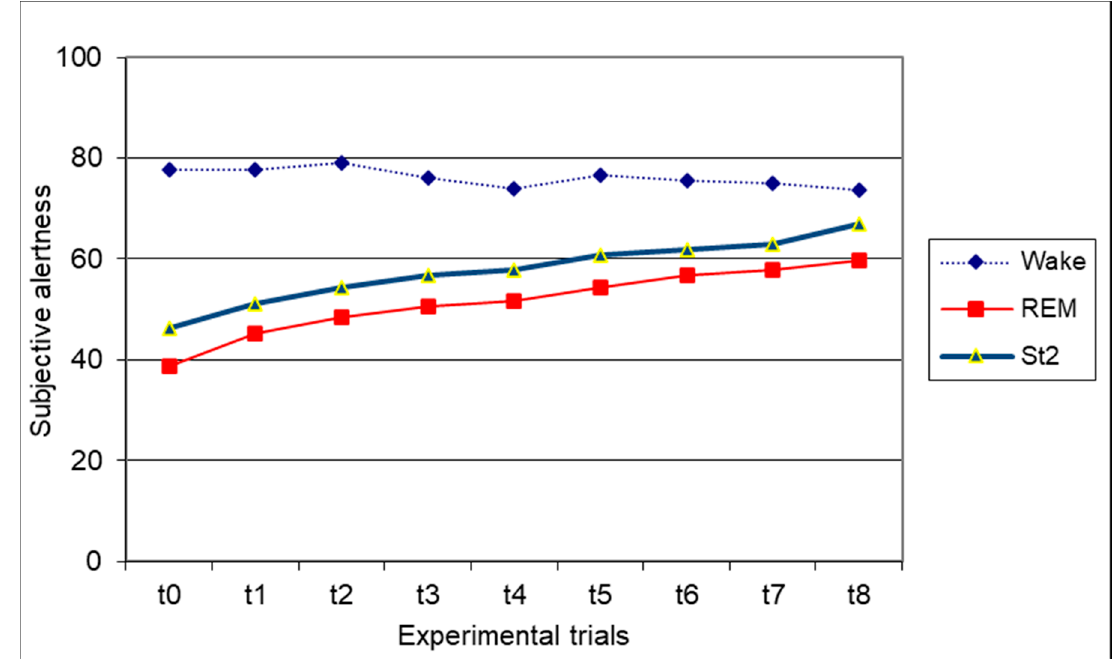
Figure 3. Graphical representation of the interaction between the experimental condition and experimental trial of subjective alertness. Mean values are reported.